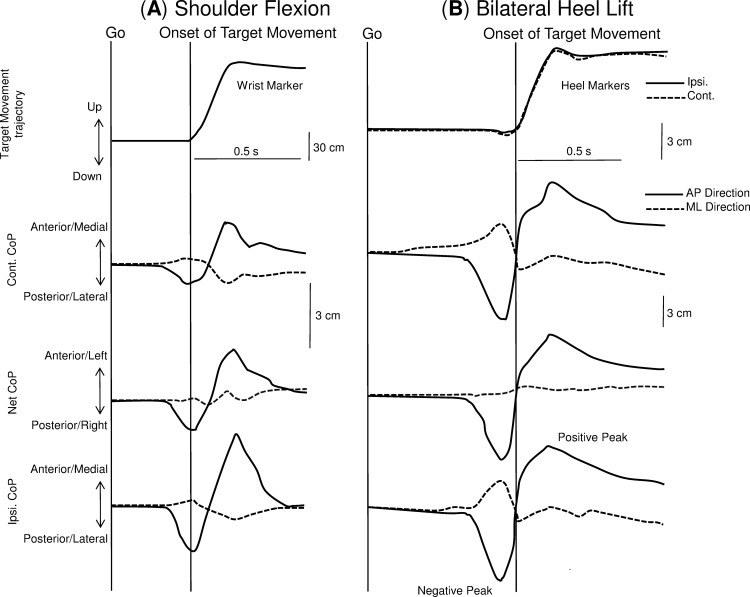
Target movement trajectory and three CoP displacements for the anterior-posterior and the medial-lateral CoP directions during the unilateral shoulder flexion task (A) and bilateral heel task (B).Onset of the target movement is illustrated as a vertical line.